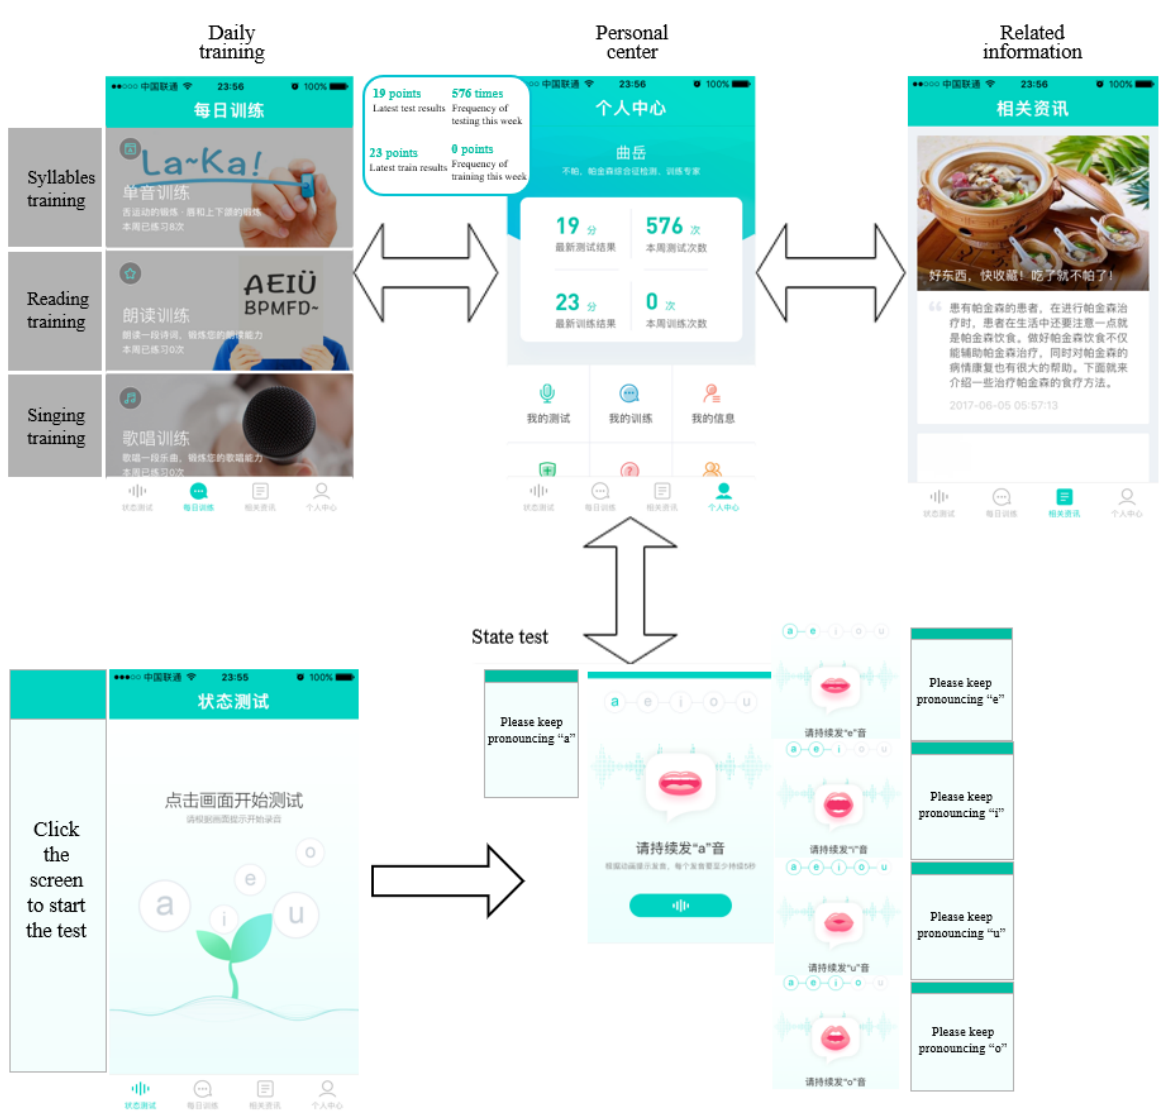
Figure 7. Screen captures from the No Pa app showing four functional